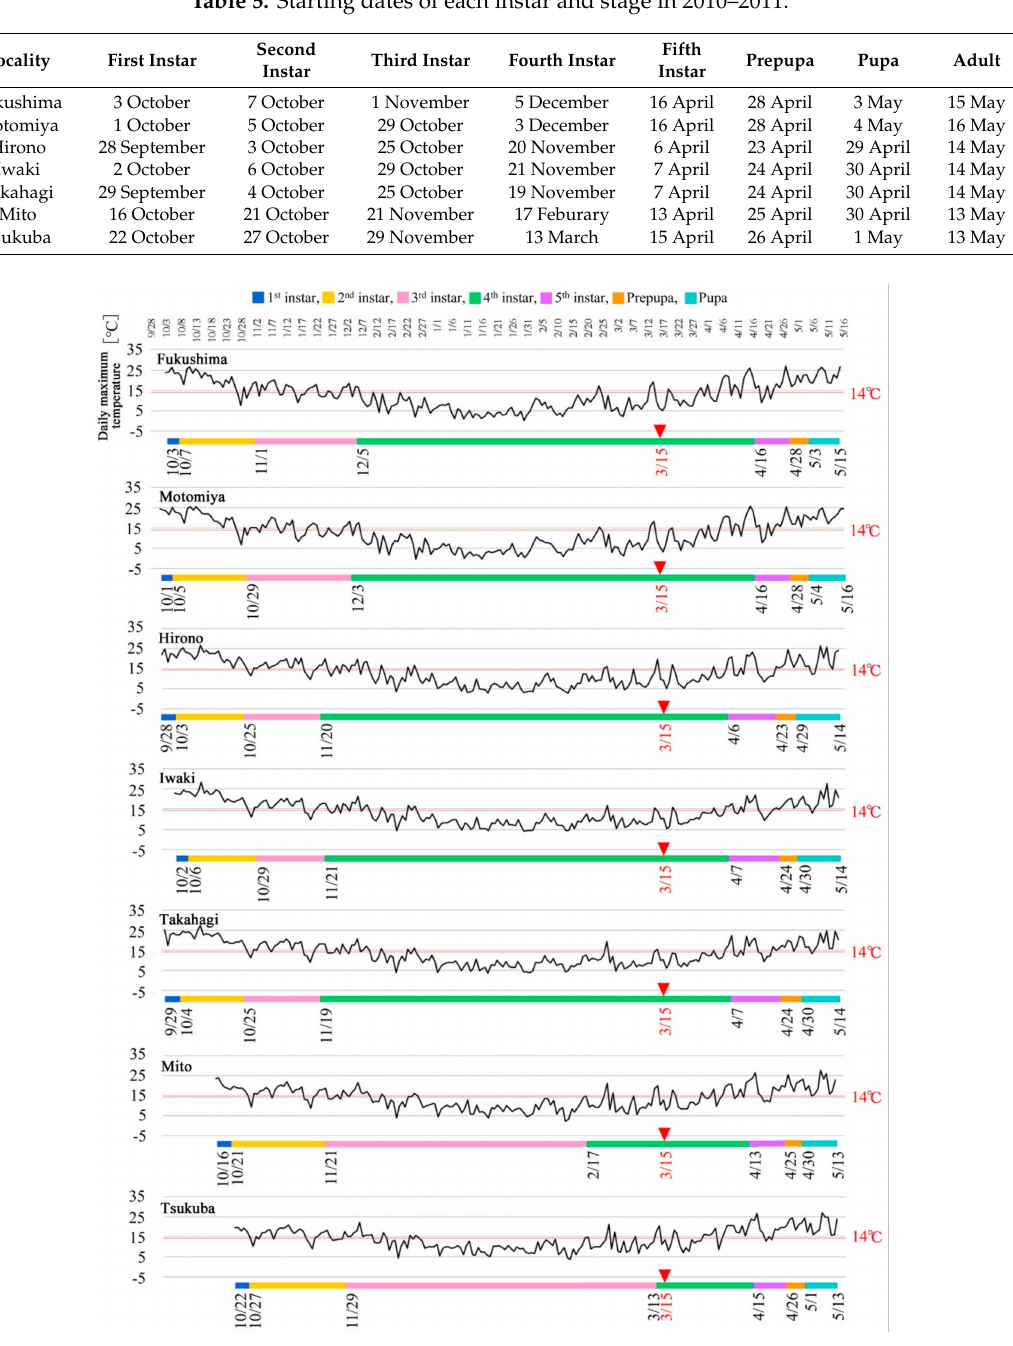
Figure 5. Timetables of developmental stages and larval instars in 2010–2011. Temporal changes in the daily maximum temperature are also shown above the timetables. The threshold temperature (14.0 ◦ C) is indicated. The greatest emission date from the FDNPP (15 March 2011) is indicated by red